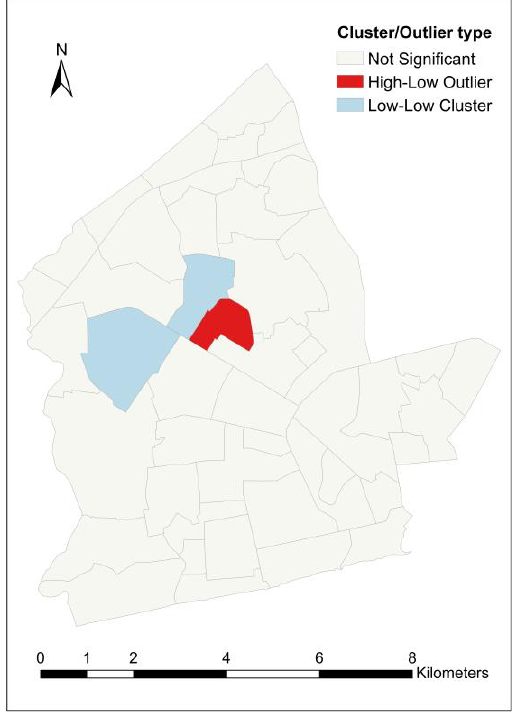
Figure 15. Cluster and outlier neighborhoods for load shedding exposure per unit area.